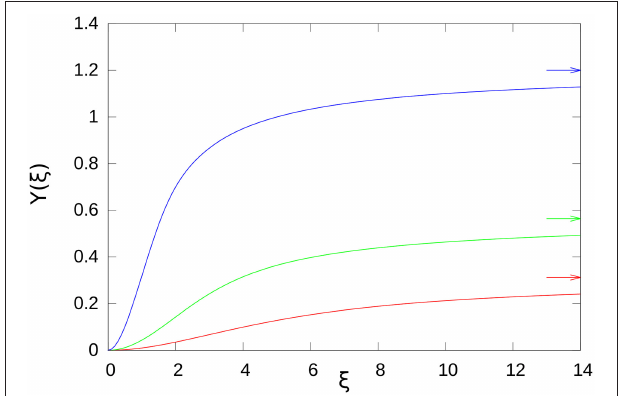
FIGURE 1 | Adimensional interaction functions Y ( ξ ) for exponential (red), Gaussian (green), and step-wise (blue) distributions. The arrows on the right indicate the corresponding asymptotic values 2 ˆ W .